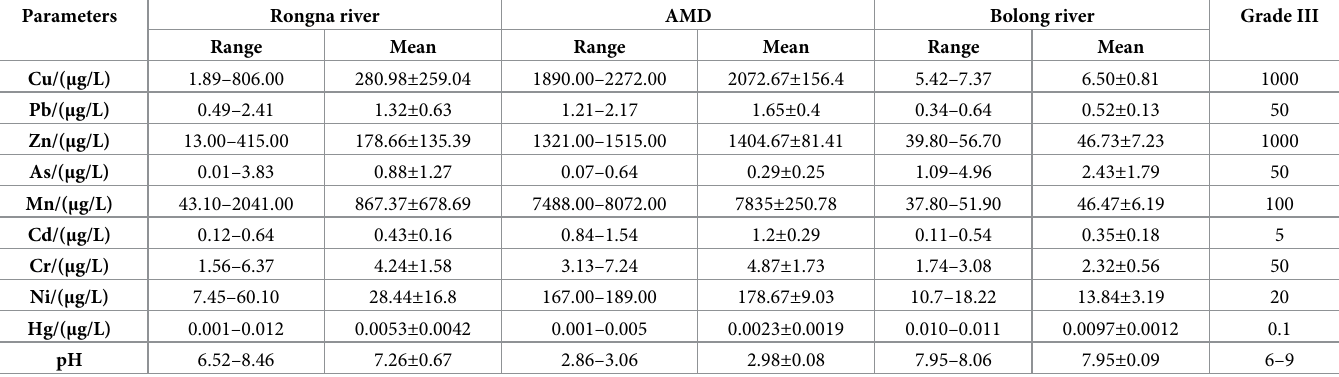
Table 4. Characteristics of heavy metal concentrations in the